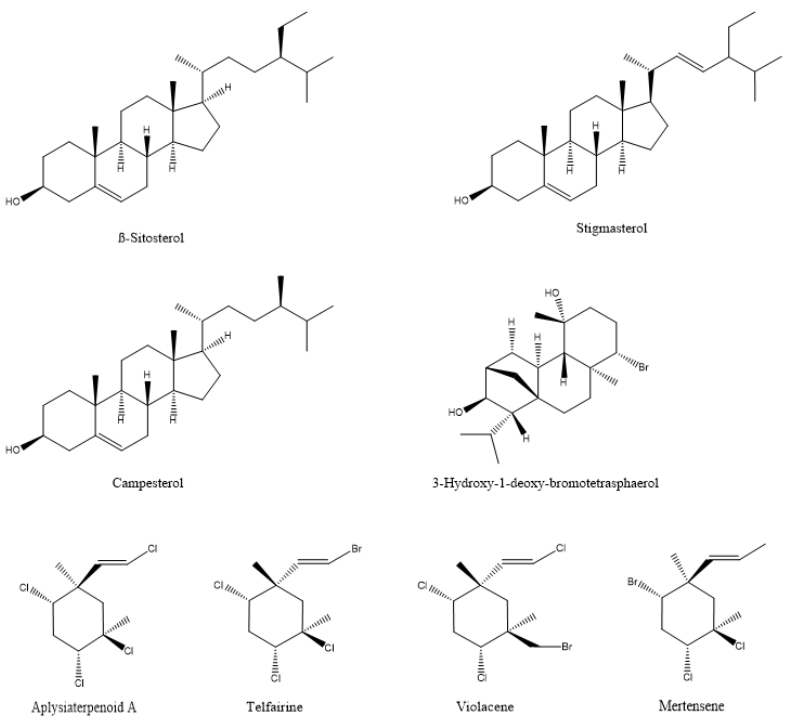
Figure 3. The chemical structure of active compounds that were isolated from Sphaerococcus coronopifolius , Plocamium cartilagineum , Plocamium telfairiae , and Prasiola crispa . Table 1. Summary of algal compounds and their antibacterial activities.